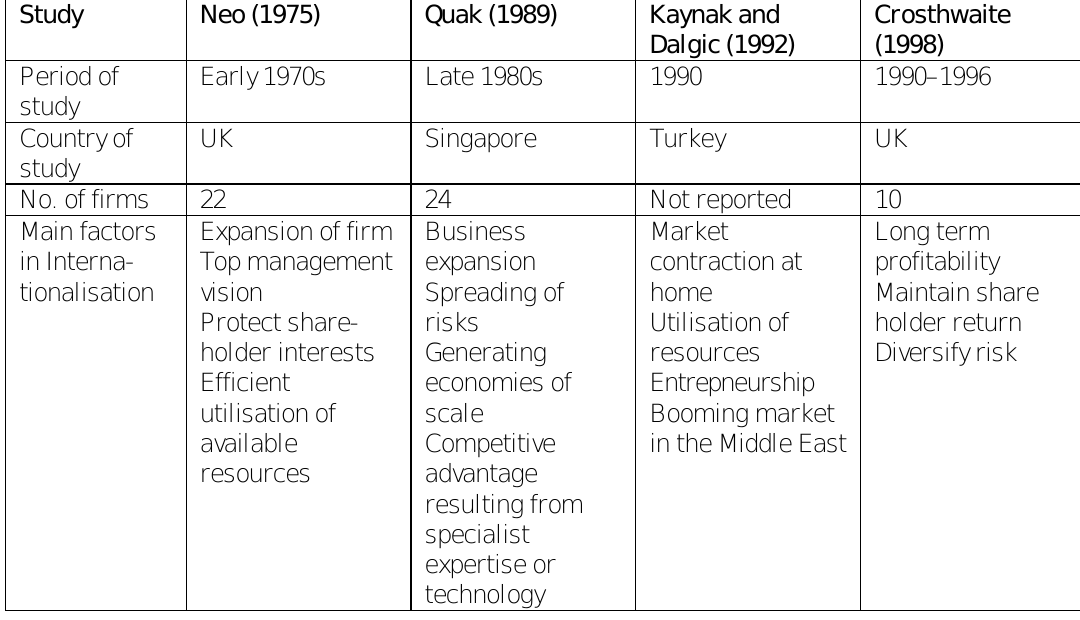
Table 1: Factors that push a firm towards internationalisation